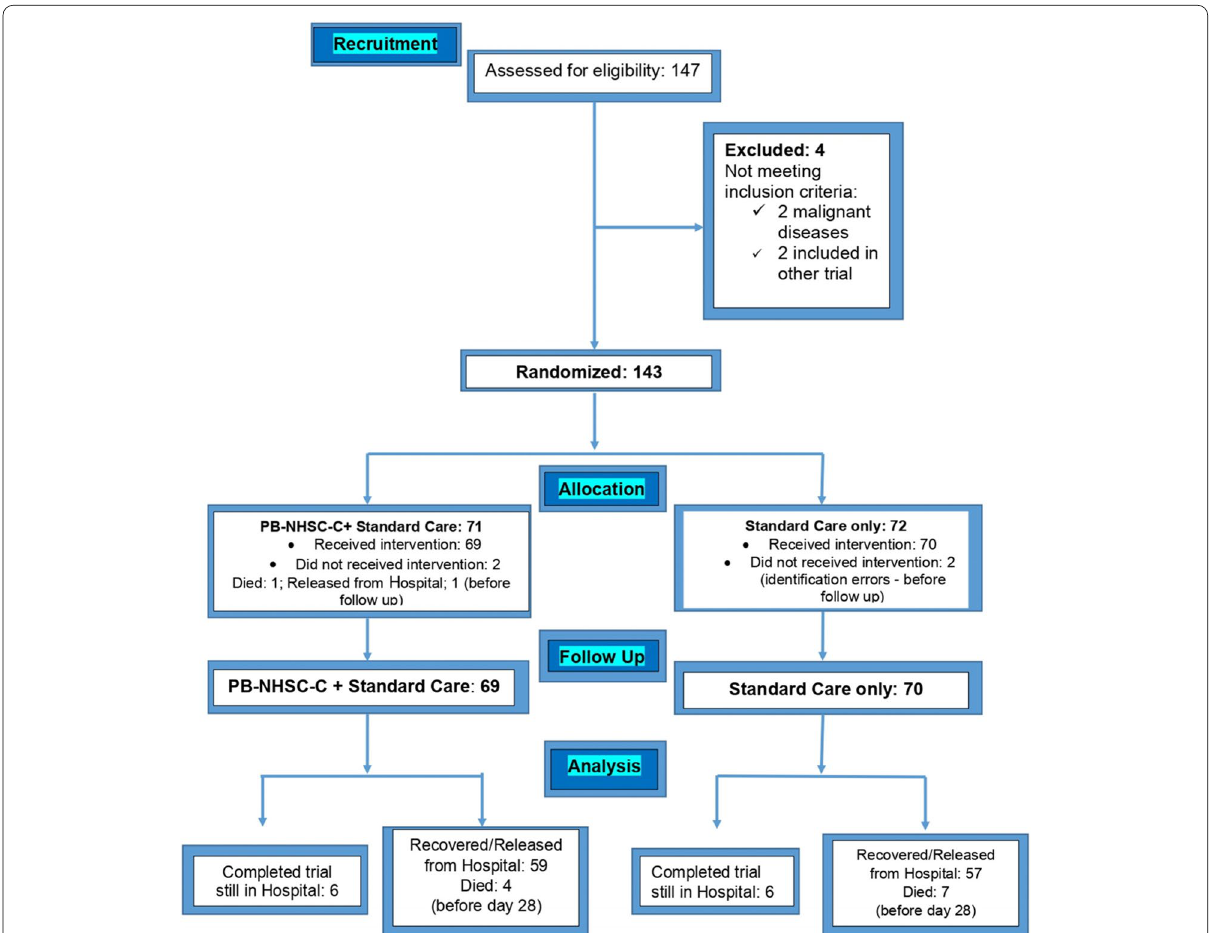
Fig. 1 Patient allocation during the SENTAD‑COVID Study. Legend: Four initially screened patients were excluded before randomization because 2 had been previously diagnosed with malignant diseases, and 2 were previously included in other clinical trials. After randomization, data from 4 additional patients were not analyzed. 2 patients in the control group had data error identifications. 2 patients were not followed in the PB‑NHESC‑C group: 1 was released from the hospital, and the other unfortunately died before the initial day of